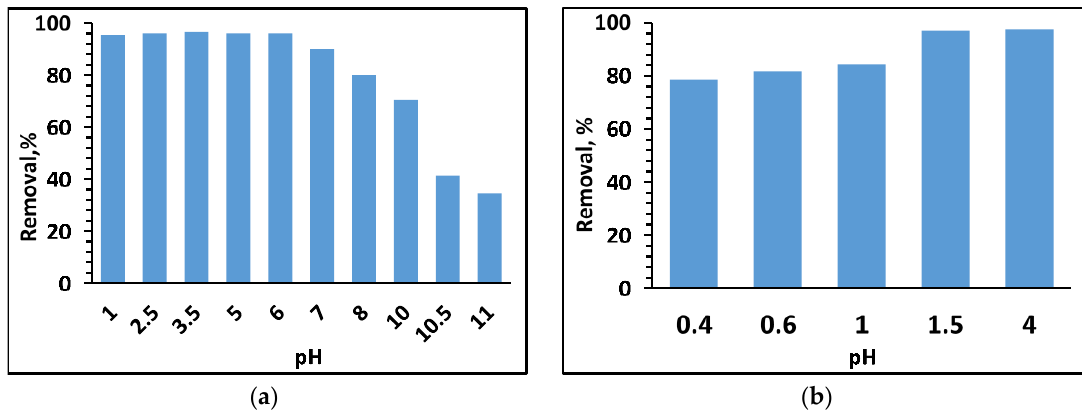
Figure 12. Removal% from a 5 mL solution at 10 ppm concentration of ( a ) rhodamine B and ( b ) phenol red at different pH values.